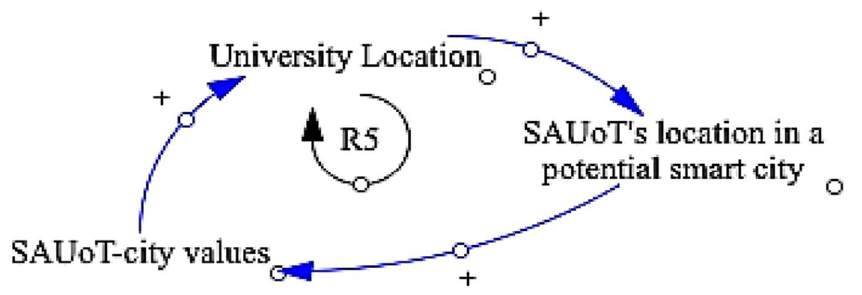
Figure 6. Reinforcing loop R5.